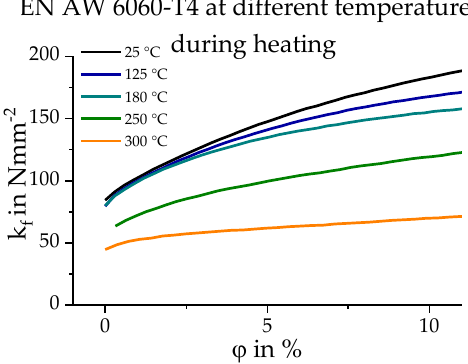
Figure 11. Experimentally obtained flow curves of imaginary phase mixture A + Z respectively Z + B